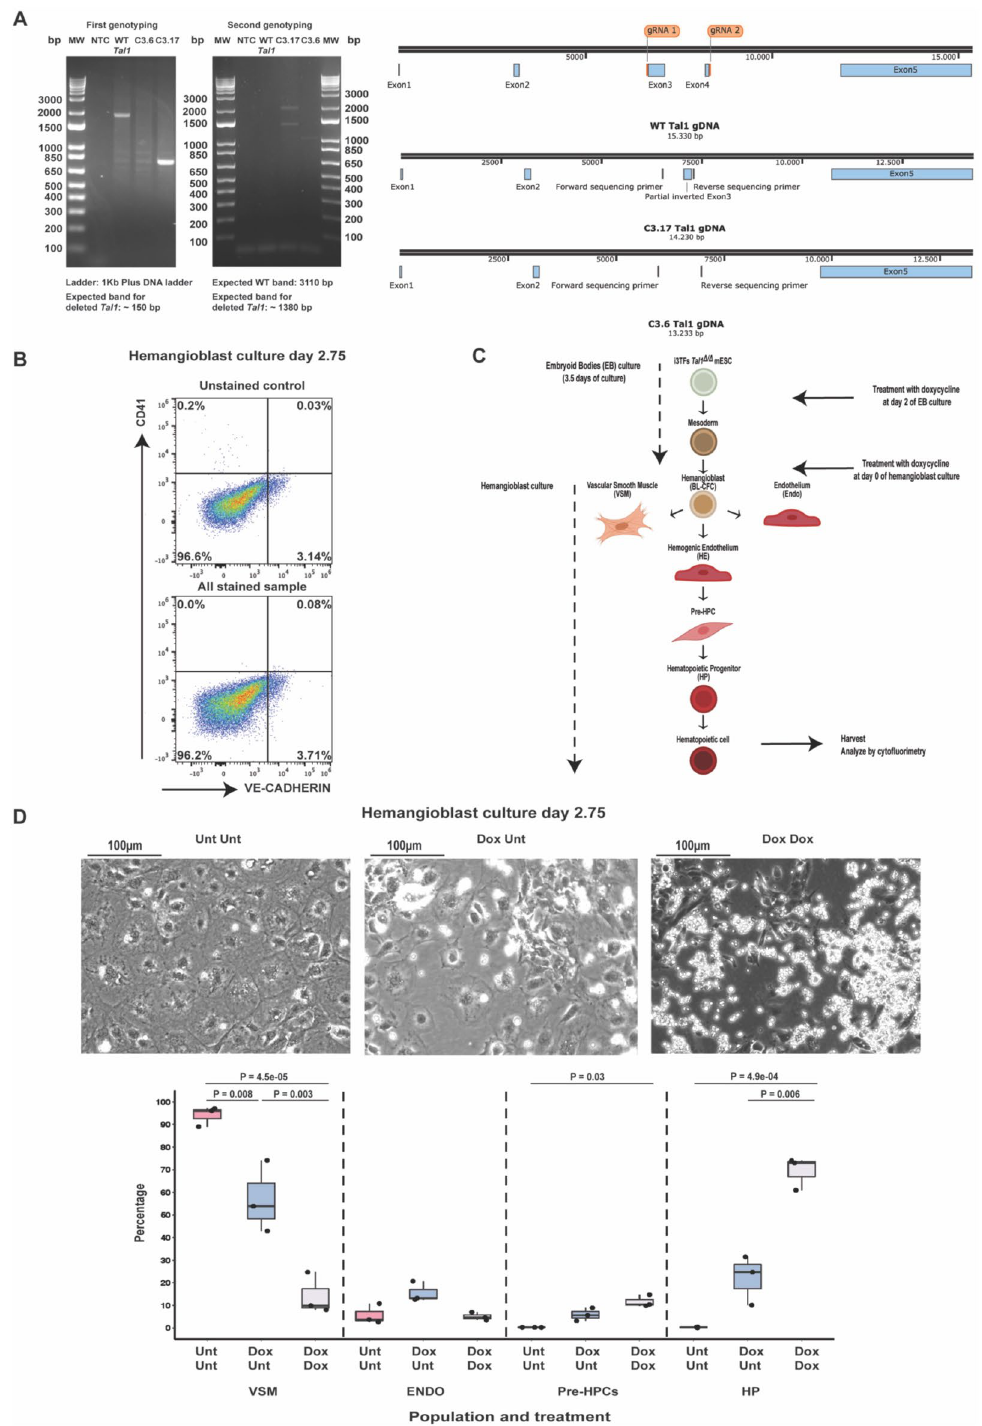
Figure 6. Characterization of the Tal1 Δ/Δ inducible 3TFs embryonic stem cell line. ( A ) Left: electrophoresis showing the genotyping of the Tal1 mutant mESCs clones used for experiments. Right: scheme of the WT Tal1 gene and the Tal1 gene from mutant clones C3.17 (allele with the shorter deletion) and C3.6 reconstructed based on the sequencing results. ( B ) Representative flow cytometry analyses of untreated day 1.75 hemangioblast cultures comparing the profile of unstained cells (top) and cultures stained for VE-CAD and CD41 (bottom). 3–4% of the cells in hemangioblast cultures were auto-fluorescent in the red (VE-CAD) channel. ( C ) Experimental layout used to characterize the mutant line. ( D ) Top: representative microscopic images of the indicated conditions. VSM cells appear as large wide-spread cells; Endo cells appear as elongated cells; HPs appear as round floating cells. Unt Unt = untreated; Dox Unt = doxycycline added at EB day 2; Dox Dox = doxycycline added at EB day 2 and at day 0 of hemangioblast culture. Bottom: box plots showing the relative frequencies of VSM, Endo, Pre-HPC and HP populations of HE culture from the indicated conditions (n = 3). Significance was determined by Analysis of Variance (ANOVA) test followed by Tukey HSD test for multiple test correction. Error bars correspond to standard